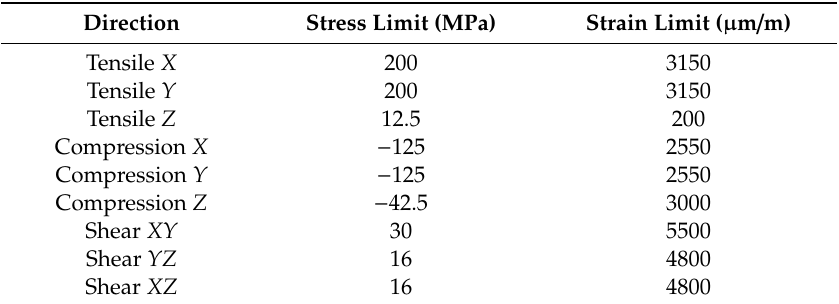
Table 6. Orthotropic stress and strain limits for inverse safety factor (ISF) computation.